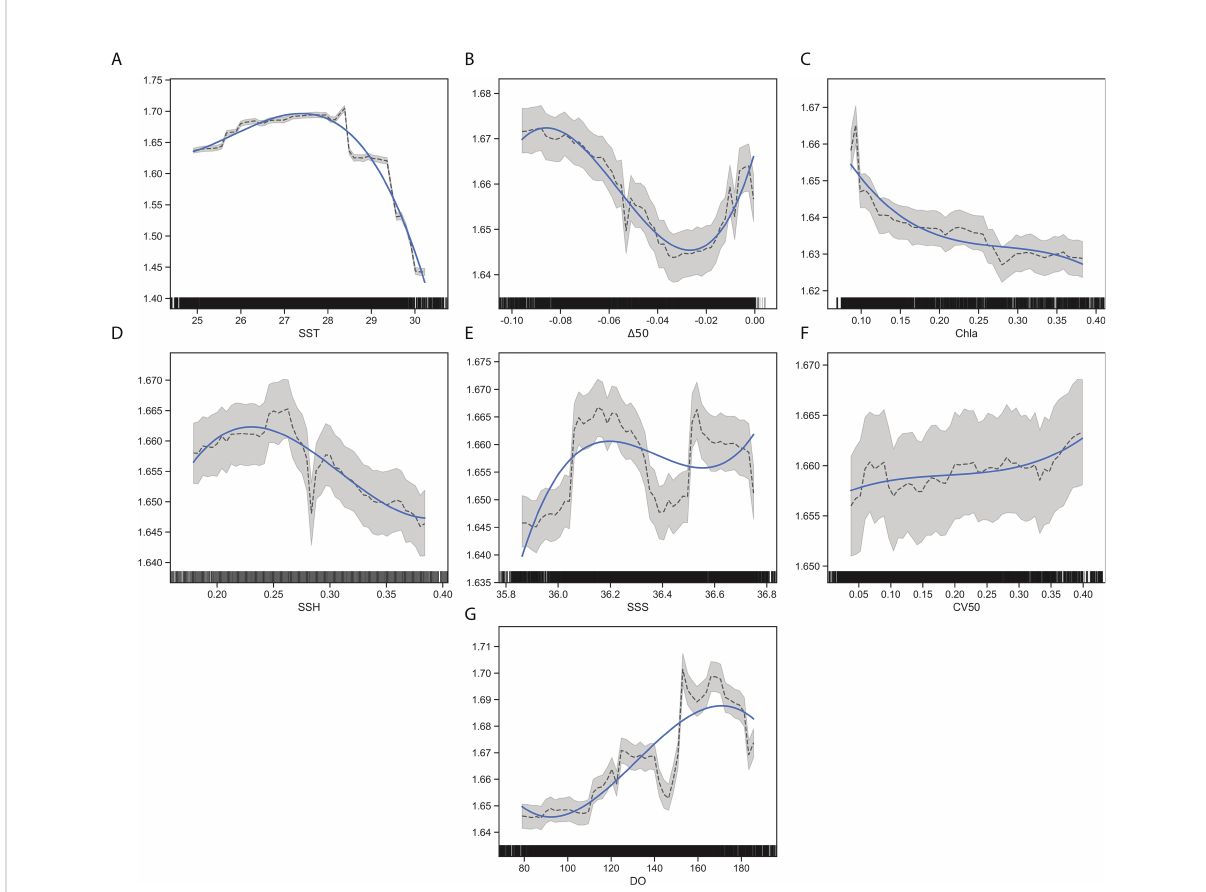
FIGURE 13 Partial correlation diagram of RF model of the in fl uence of environmental variables on CPUE. (A) SST, (B) △ 50, (C) Chla, (D) SSH, (E) SSS, (F) CV50, (G) DO, the black curve is the in fl uence curve of variable on CPUE, the blue curve is the fi tting of the trend of the in fl uence curve, and the gray area is the 95% con fi dence